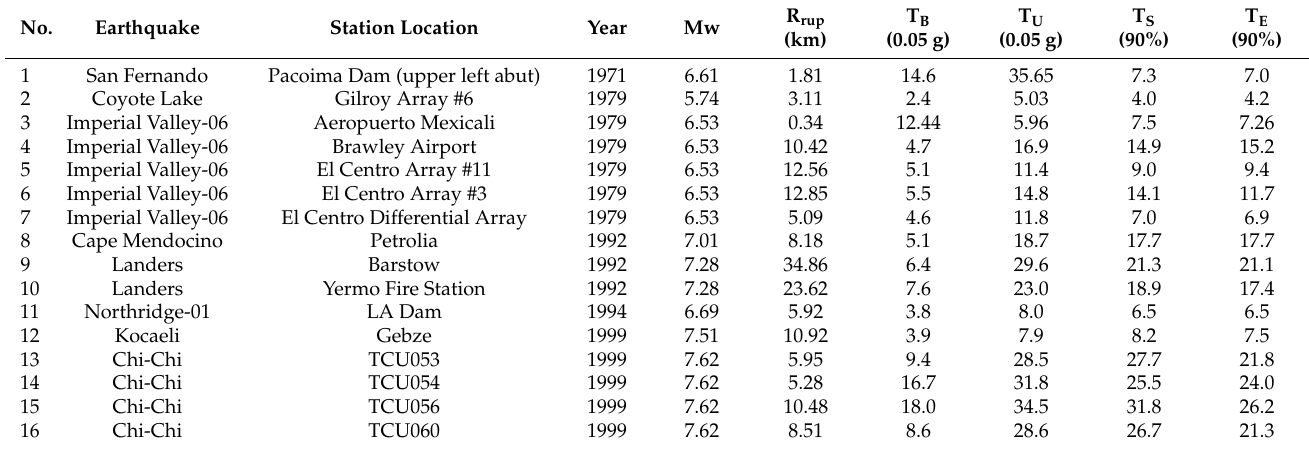
Table A1. The main information of 16 as-recorded NFGMs is considered in this